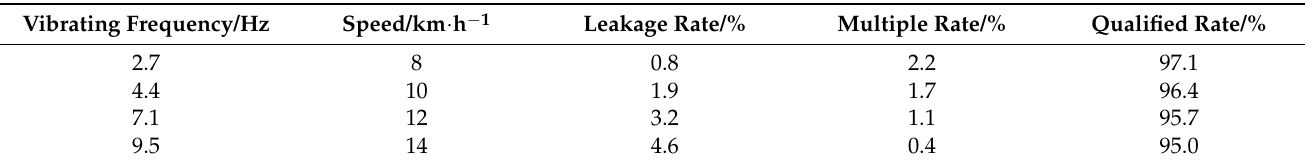
Table 6. Experimental